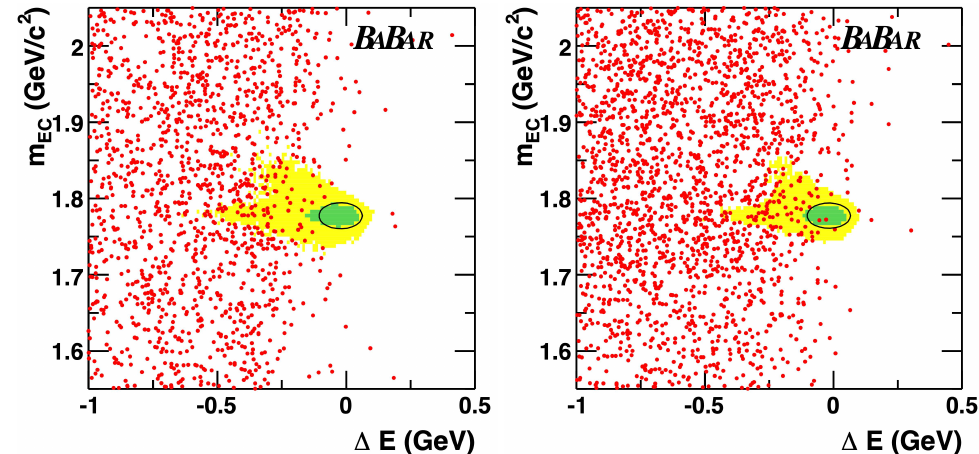
Figure 4. Two-dimensional distributions in the m E C vs. ∆ E plane for the B A B AR searches [69] for τ − → e − γ ( left ) and τ − → µ − γ ( right ) decays. Data are shown as dots and contours containing 90% (50%) of signal MC events are shown as light-yellow (dark-green) shaded regions, along with the 2 σ contours shown as black ellipses. This figure has been reprinted with permission from Ref.